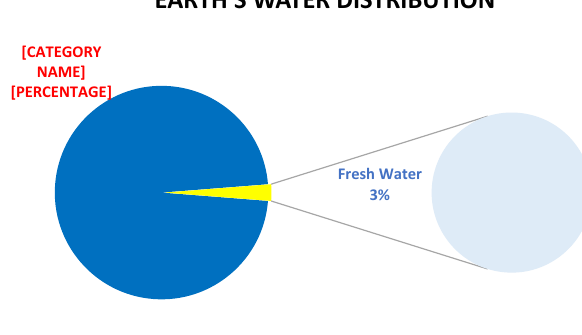
Fig. 1 Percentage of earth’s water sources